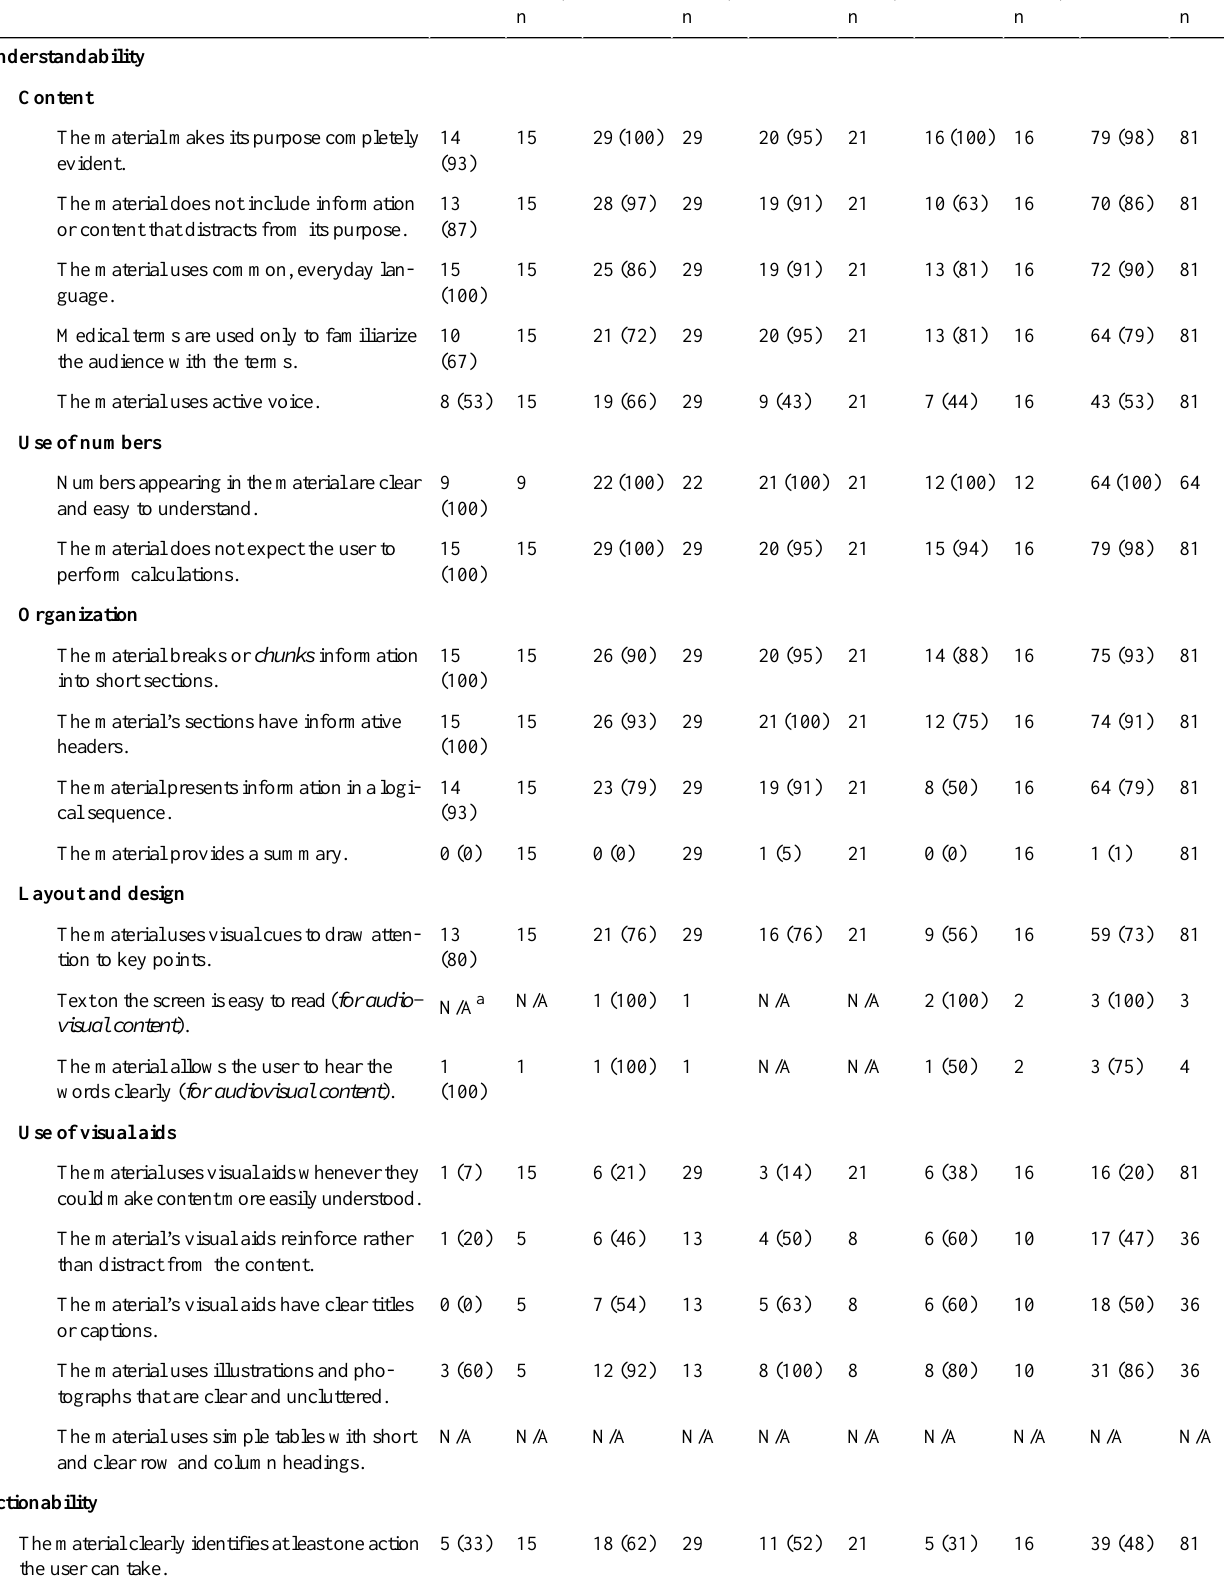
TotalFor-profit organi- zationsNot-for-profit or- ganizationsAcademic hospi- talsNonacademic hospitalsPatient Education Materials Assessment Tool